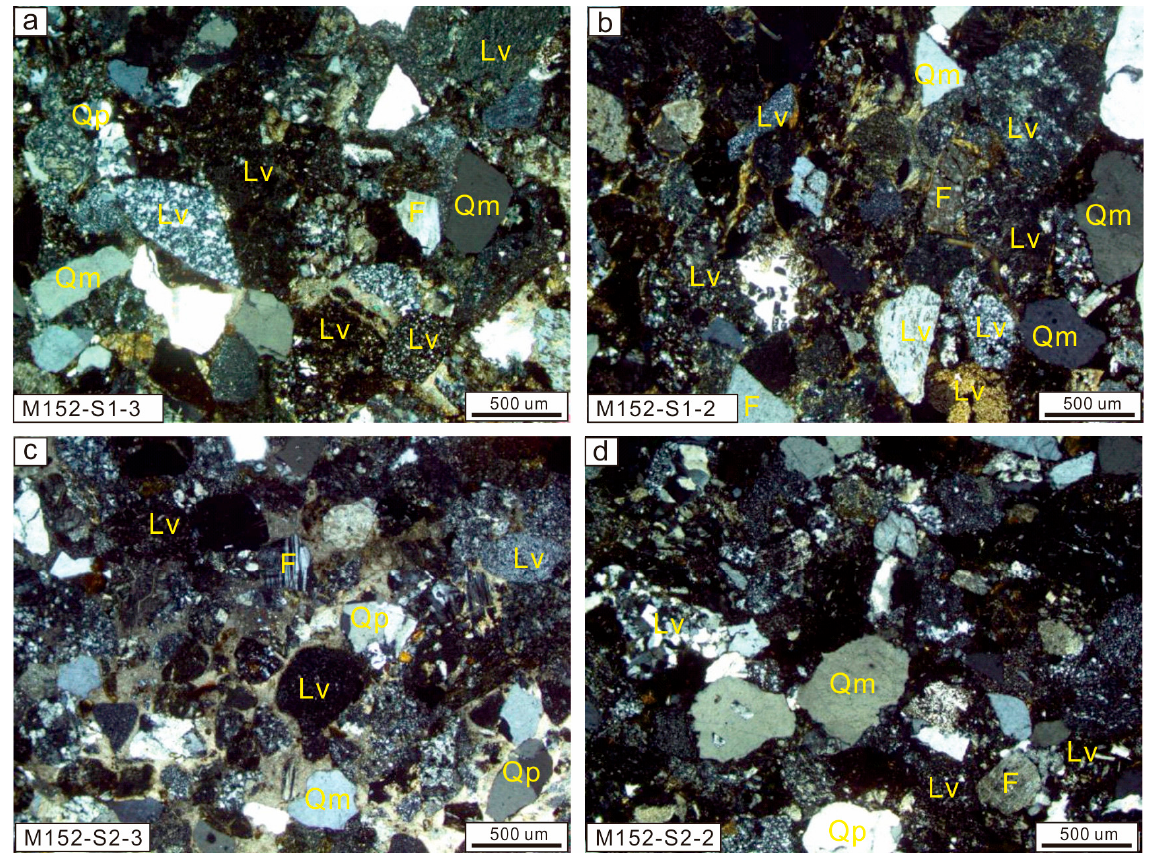
Figure 3. Photomicrographs showing the compositional characteristics of the sandstone M152-S1 ( a , b ) and M152-S2 ( c , d ) from Baikouquan Formation of Well M152. Abbreviations: Qm-monocrystalline quartz; Qp-polycrystalline quartz; F-Feldspar; Lv-volcanic lithic fragments.